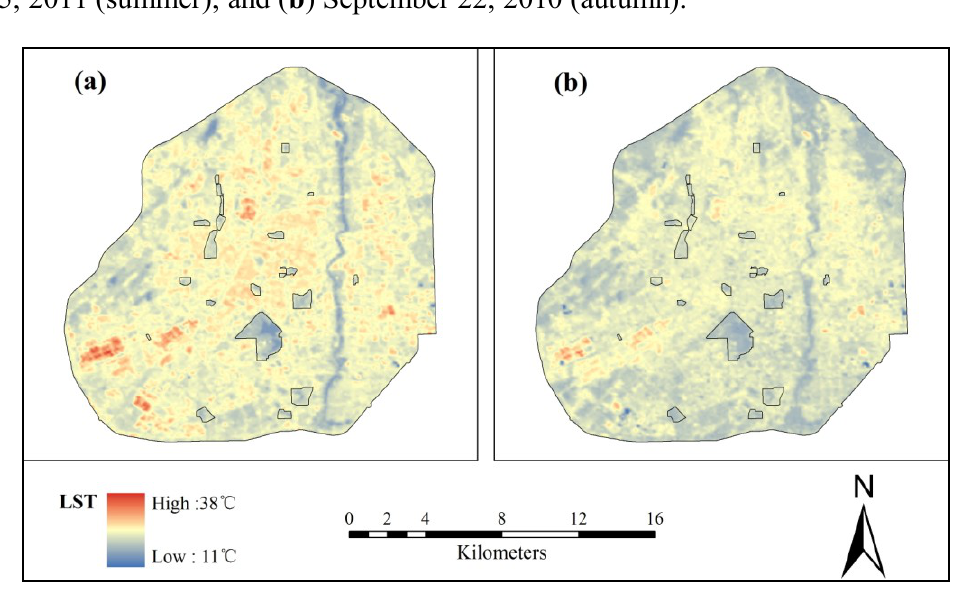
Figure 3. The land surface temperature (LST) map of the study area in Changchun: ( a ) June 5, 2011 (summer), and ( b ) September 22, 2010